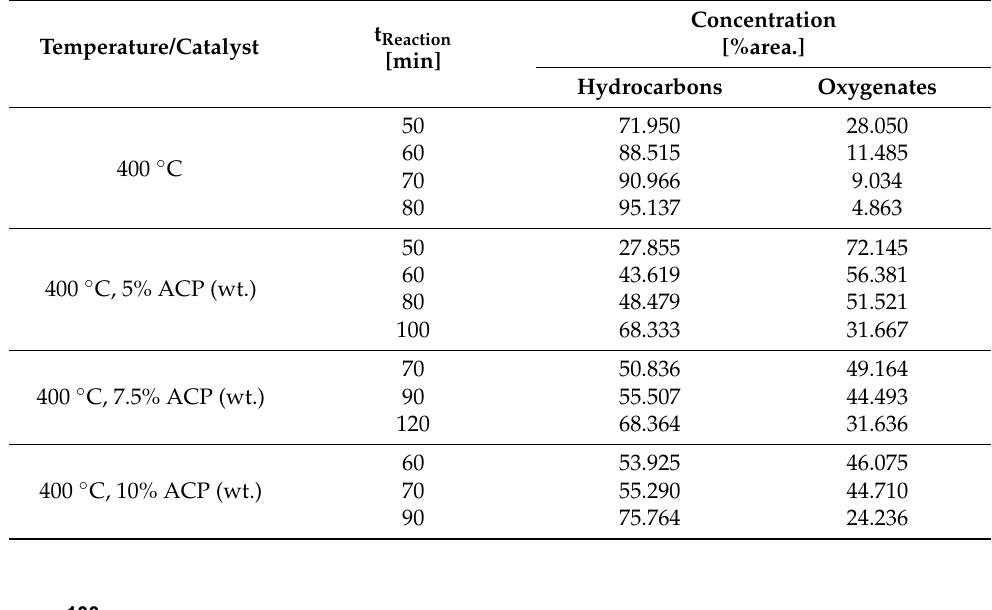
Table 5. Effect of reaction time on the concentration of bio-oil by catalytic upgrading of residual fat pyrolysis vapors at 450 ◦ C, 1.0 atm, 0.0, 5.0, 7.5, and 10.0% (wt.) activated carbon pellets impregnated with 10.0 M NaOH, using a catalyst fixed-bed reactor, in a semi-pilot scale two-stage reactor of 2.0 L.